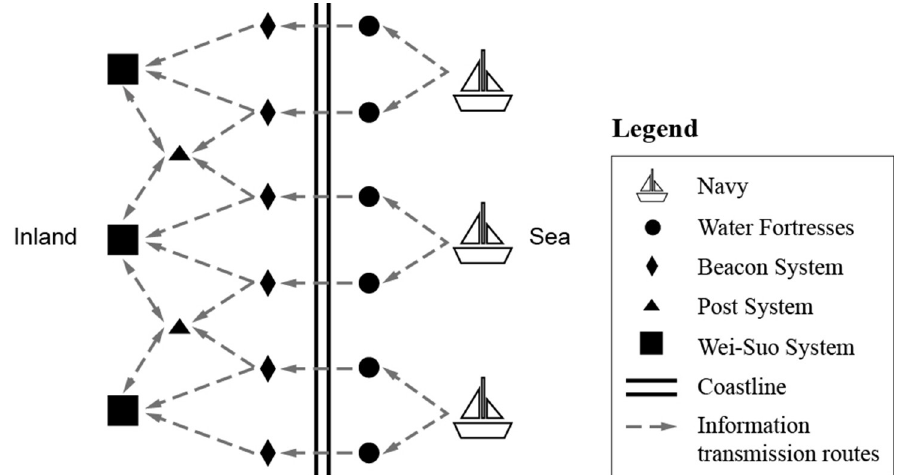
Fig 2. Coastal defense hierarchical